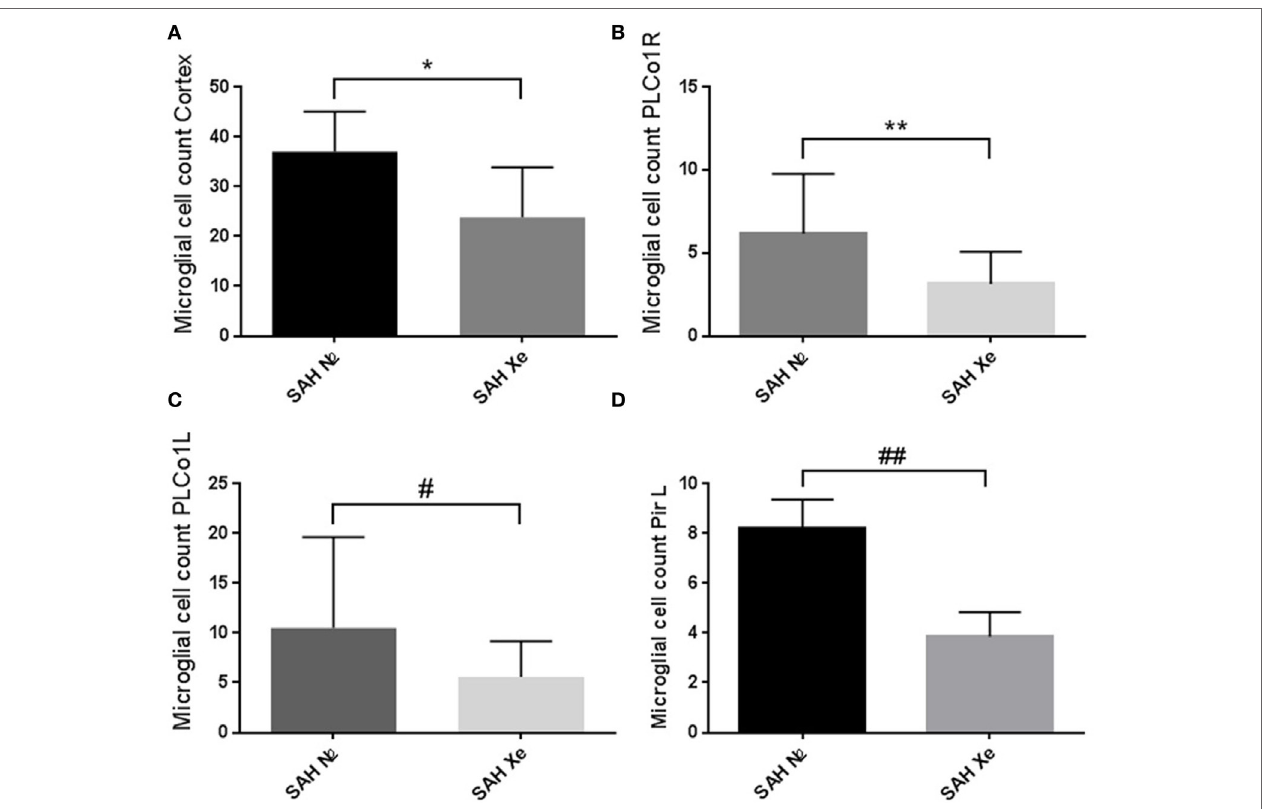
Figure 6 | Cortical microglial cell count. Software assisted counting of Iba-1 positive cells in four cortical regions. (a) Comparing the summed up absolute cell count per animal, the xenon-treated animals showed a lower overall microglial cell count compared to the control groups, * p = 0.1206. (B,c) Regions closer to the bleeding source showed a higher number of activated microglia (highest damage in the PLCo1L region) with an increase in the difference between treatment groups without statistical significance, ** p = 0.1680, # p = 0.1002. (D) The difference in cell count was statistically significant in the left side piriform cortex (pir1 L). 8 ±1.16 microglial cells were counted in the control group vs. 4 ± 1.07 in the xenon group, ## p =